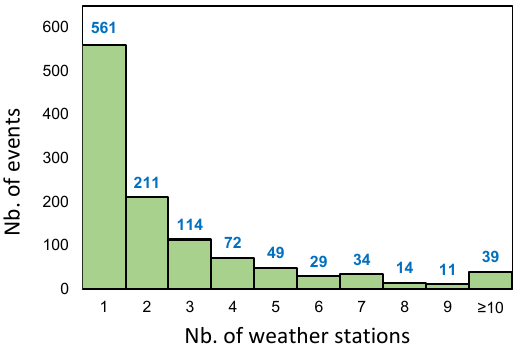
Figure 3. Distribution of SHHPs, according to the number of weather stations with an SHHP event record on the same day. The number of events is shown on top of each bar.